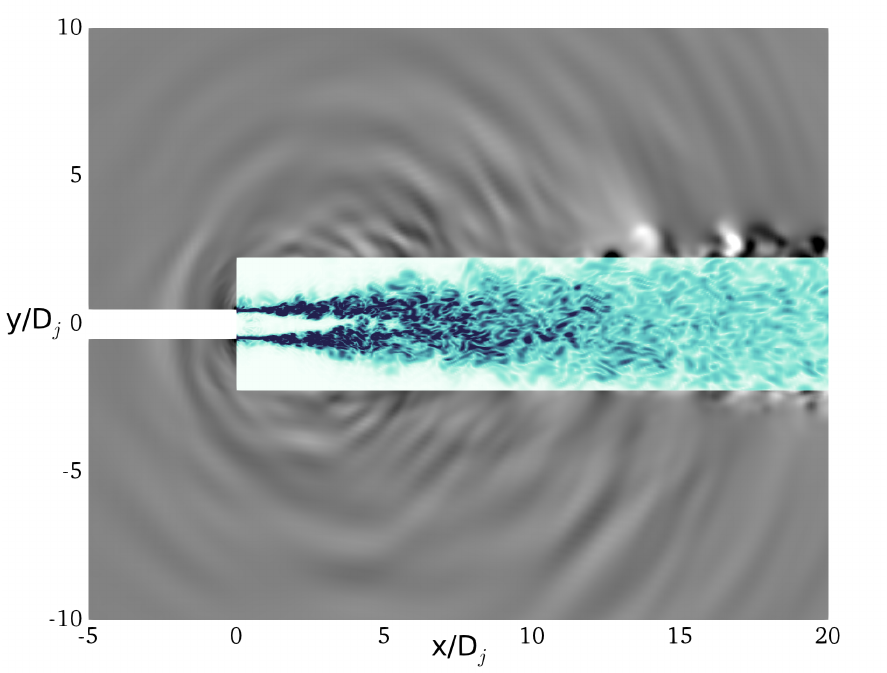
Figure 7. Vorticity and Pressure in the Near-Field for the Jet for the Present Simulation. Vorticy contour levels range from 0 to 4 ω D j / a ∞ and pressure contours range from − 0.0015 to 0.0015 p / ρ ∞ a 2 ∞